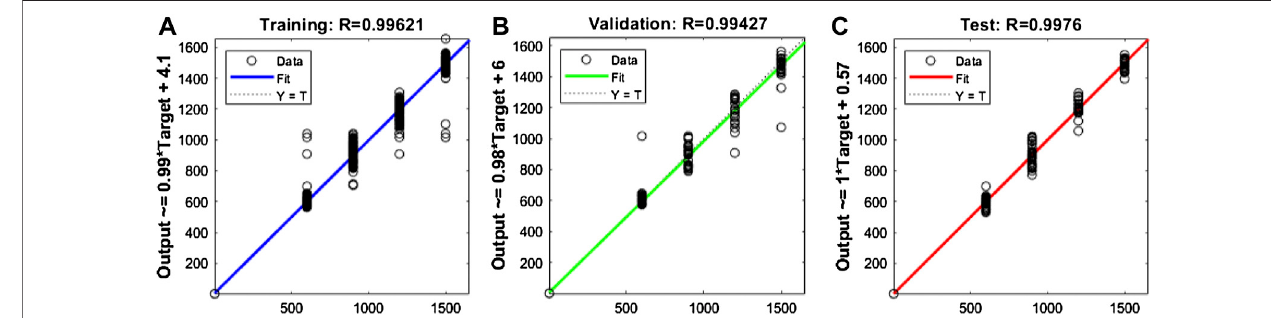
FIGURE 7 | Scatter plot for (A) training (B) validation, and (C) test dataset distributions.